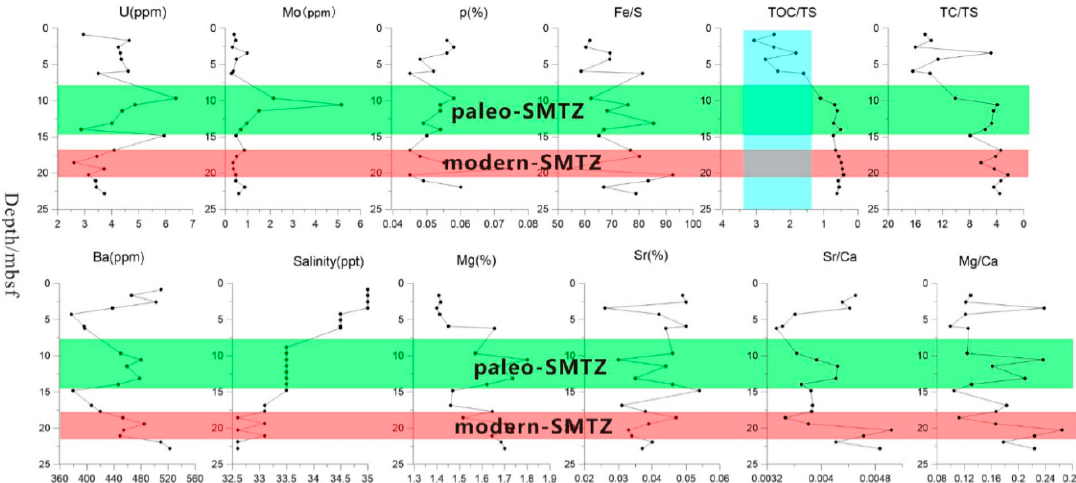
Figure 3. In the picture, the green represents paleo-SMTZ, and the red represents current-SMTZ. Changes in U and Mo coupling indicate that the paleo-SMTZ horizon was a reducing environment and the modern SMTZ was an oxidizing environment; the P element in the sediment had obvious enrichment in the modern SMTZ horizon and the paleo SMTZ layer; a large amount of pore water was released due to metal-AOM, resulting in a significant decrease in pore water in the paleo-SMTZ layer and the modern SMTZ. The Mg/Sr ratio had opposite trends between the paleo-SMTZ and modern SMTZ. This was mainly due to different stages of AOM.